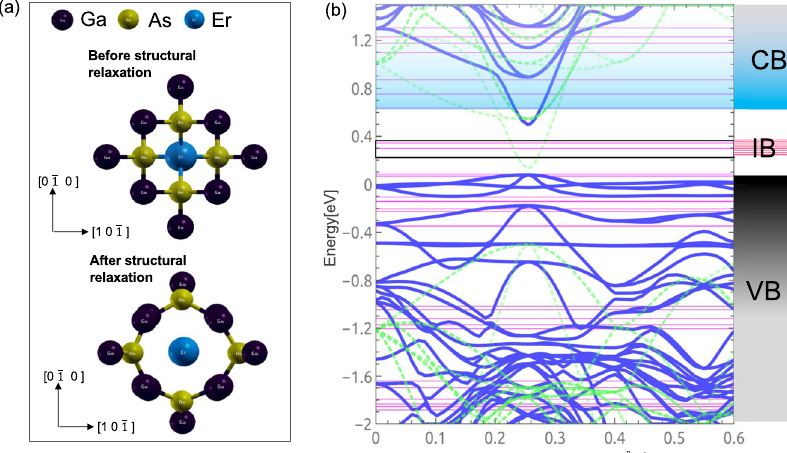
Fig. 6 Density functional theory (DFT) simulation results. a Local structure relaxation around the Er atom and b calculated band structure of Er-doped GaAs, respectively. Three types of structure models were implemented: the 2-atom GaAs basis model (blue line), the 12-atom Ga 5 As 6 Er basis model (green line), and the isolated Ga 12 As 4 Er nanocluster (pink line), respectively. Here CB, VB, and IB stand for conduction band, valence band, and intermediate band,